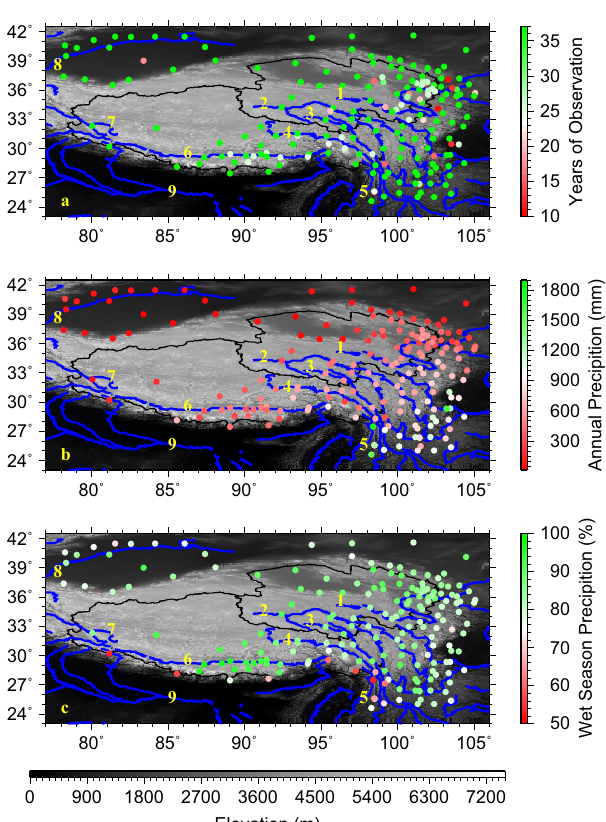
Figure 2. Geographic locations and number of years of observation for 185 stations that have observation periods longer than 10 years during 1979–2015 ( a ); mean annual precipitation at the 185 stations during 1979–2015 ( b ); percentage of wet season (May–September) precipitation to annual total precipitation at the 185 stations ( c ). Black lines denote the boundaries of the Qinghai Province on the northeastern and the Tibetan Autonomous Region on the southwestern TPS. Blue lines and the numerical numbers represent the 9 major rivers that originate from the TPS: 1: the Yellow River, 2: the Yangtze River, 3: the Mekong River, 4: the Salween River, 5: the Irrawaddy River, 6: the Brahmaputra River, 7: the Indus River, 8: the Tarim River, and 9: the Ganges River. This figure was plotted using the Generic Mapping Tools (GMT) V4.5.0